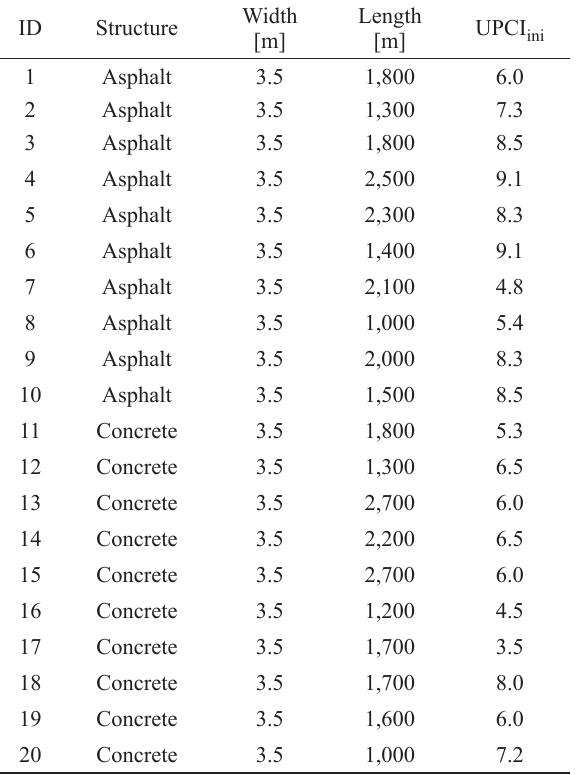
Table 1. Inventory data parameters and network initial conditions considered in the analysis